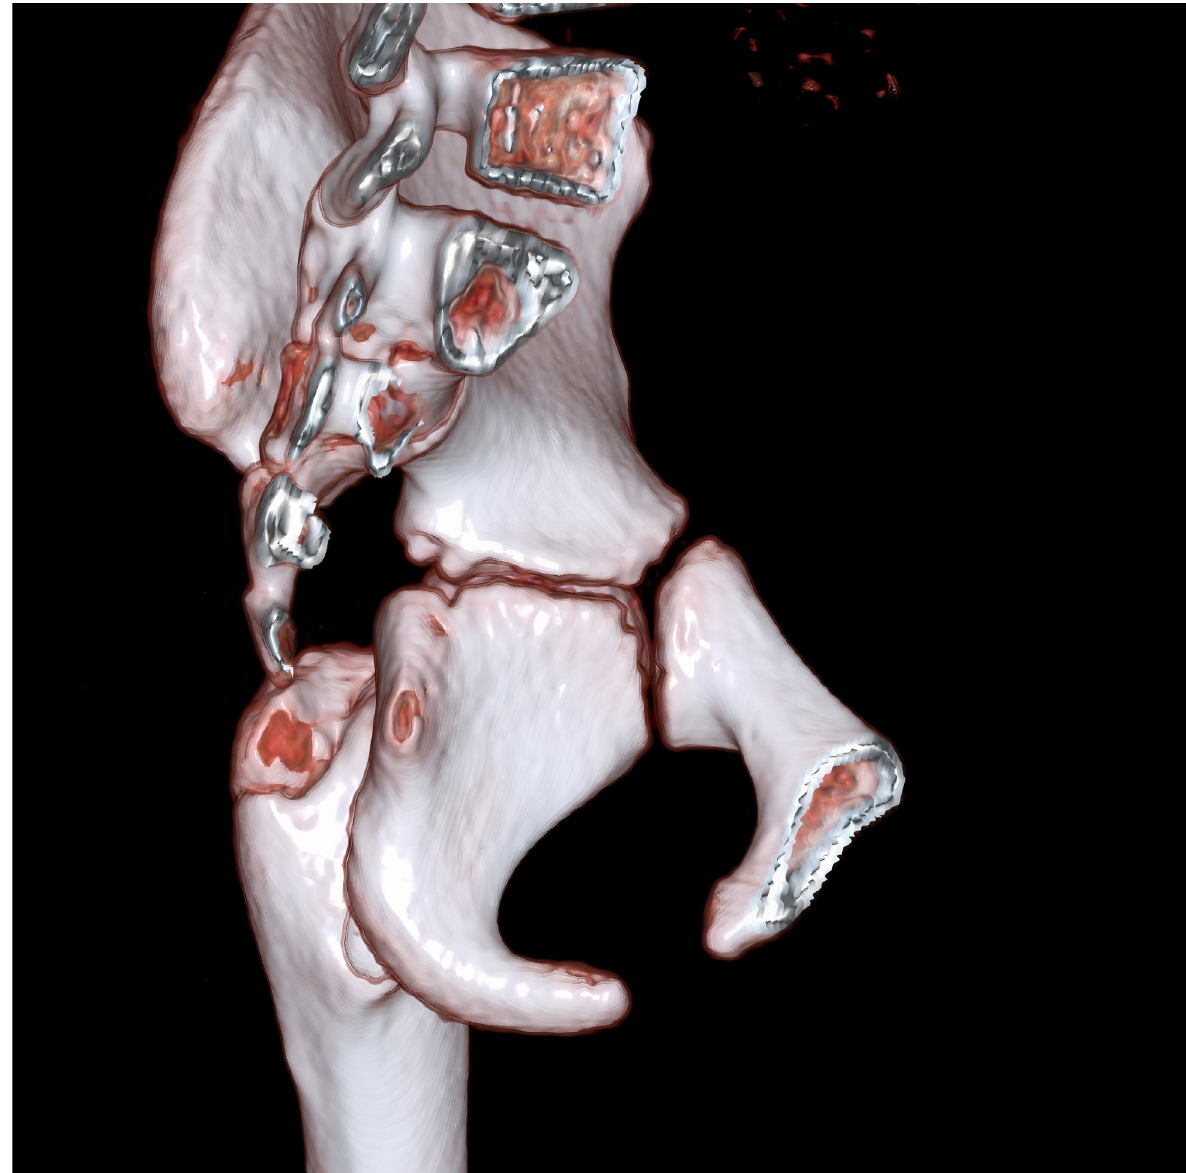
Fig 2. For a patient who is an 8-year-old girl, the virtual rendering technique (VRT) computed tomography image shows that all three synchondrosis regions were open.